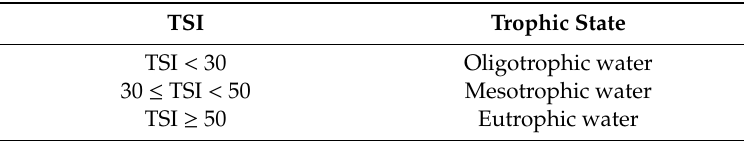
Table 2. Classification of water quality using Z sd -based trophic state index (TSI) proposed by Carlson